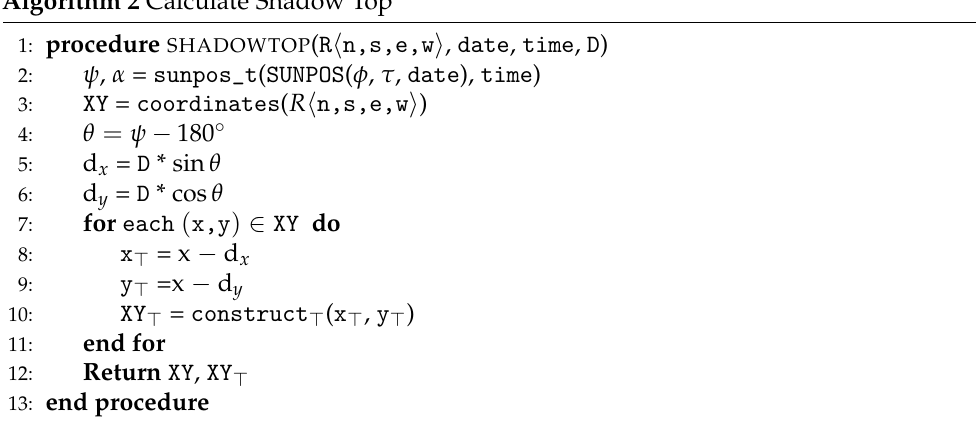
Algorithm 2 Calculate Shadow Top